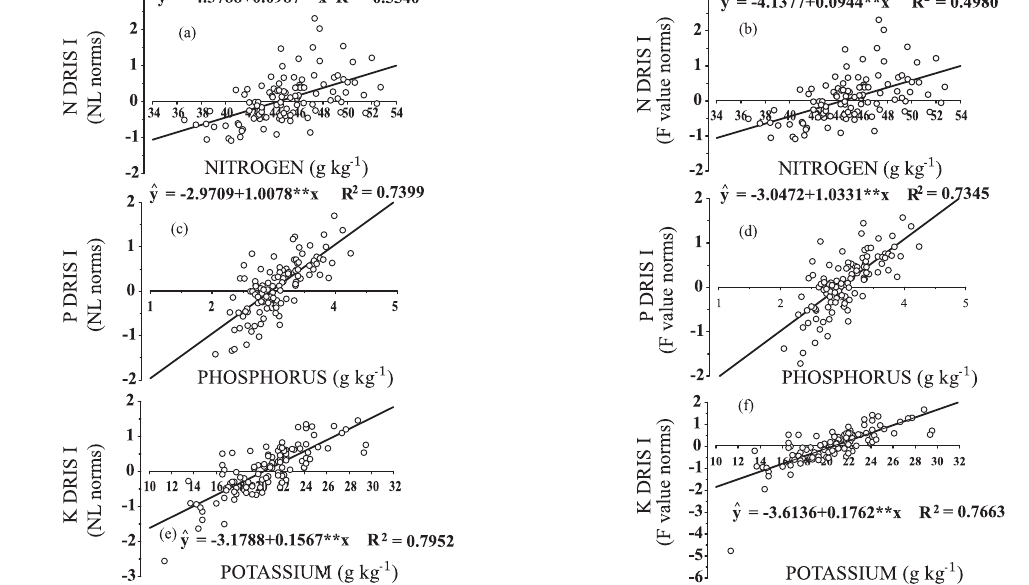
figure 1. Relationship between the primary macronutrient (reference and non-reference population) and their respective DRis indices (DRis i), generated by the norms based on the criterion of natural log transformation (nl) (a, c and e) and the norms determined by the f value (b, d and f). ** indicates p <